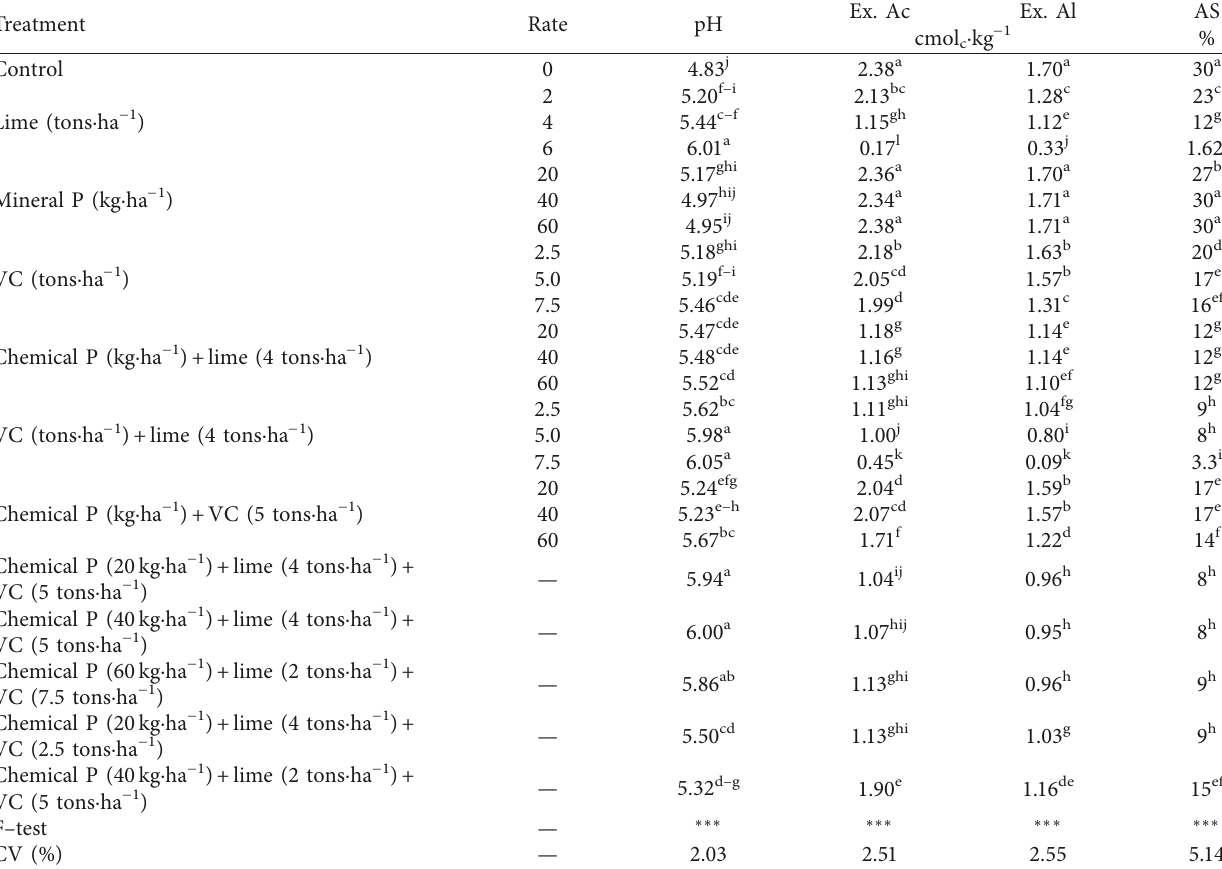
Table 3: Effects of the treatments on pH, exchangeable acidity and exchangeable Al, and percent acid saturation of soil in the incubation